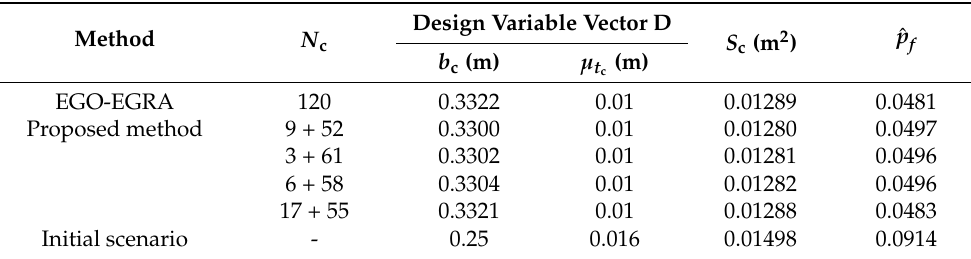
Figure 6. The response of the added samples in Example 1. ( a ) N I = 9. ( b ) N I = 3. ( c ) N I = 6. ( d ) N I = 17. Table 4. Optimization results of Example